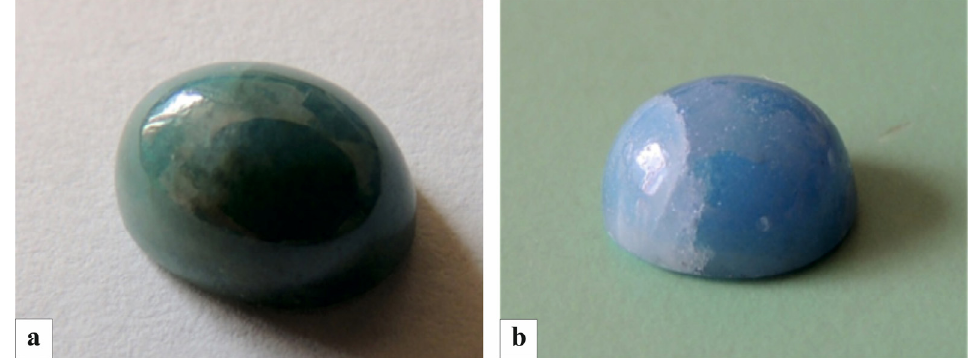
Figure 7. Cabochon-cut gem samples 1 ( a ) and 2 ( b ), from the left side of the Sissone valley. Dimensions: